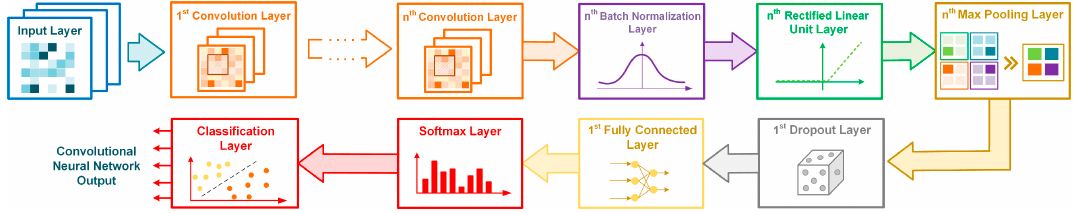
Figure 1. The basic structure of the convolutional neural network.